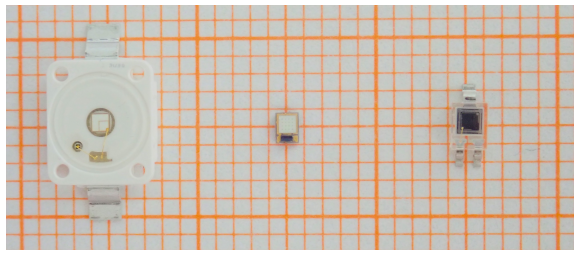
Figure 1. This picture shows an LED of the Osram Golden Dragon series on the left side, an LED of the Lumileds Z series in the middle, and the reference photodetector Osram SFH 2400 on the right side. The grid size is 1 by 1 mm. Table 1. Key parameters of tested LEDs used as photodetectors.